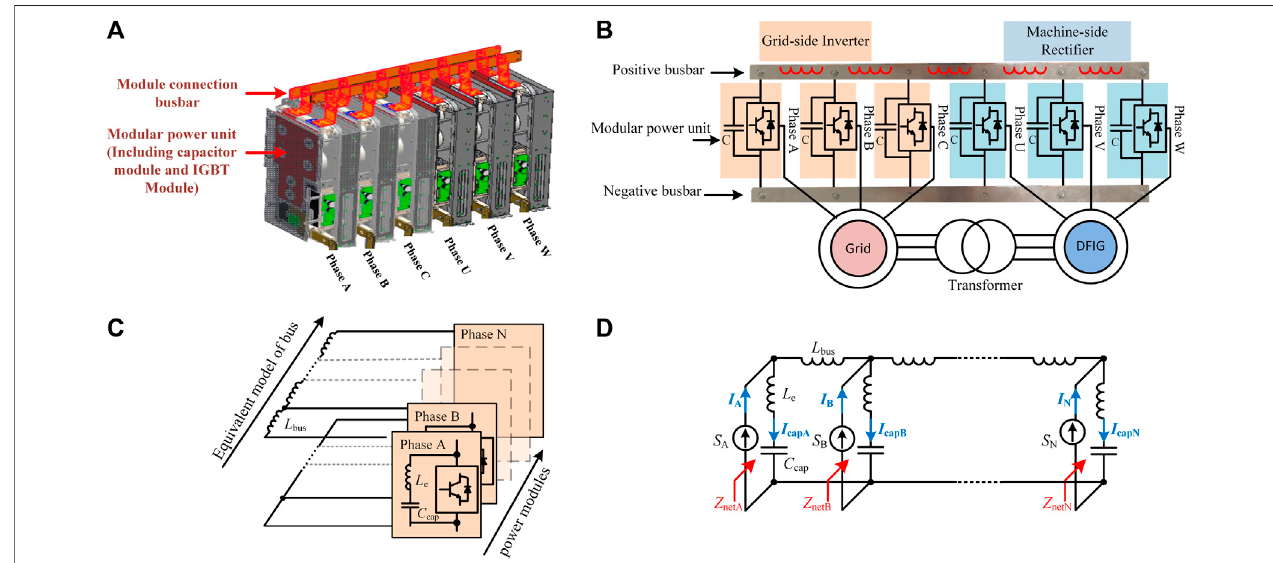
FIGURE 1 | (A) Three-dimensional structure of the DC link of two-level back to back converter (B) Back to back converter topology (C) Combined impedance network of power module and busbar (D) Equivalent topology of busbar impedance network.